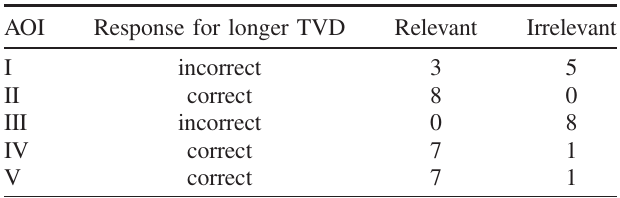
TABLE II. Expert rating regarding the solution relevance for AOIs of item 18.